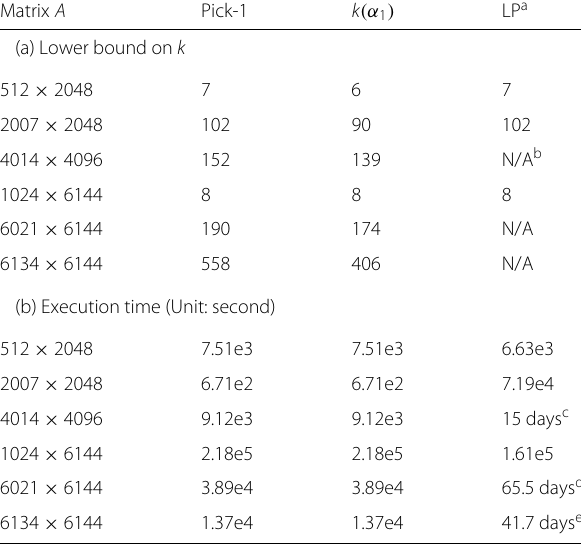
Table 3 Lower bound on k and execution time (Gaussian matrix) Matrix A Pick-1 k (α 1 ) LP a